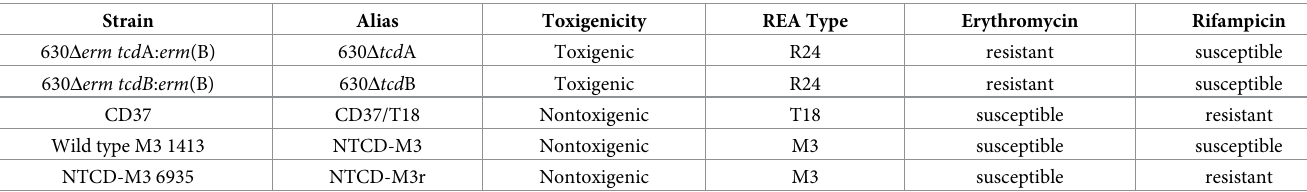
Table 1. Antibiotic resistance characteristics of C . difficile strains used in passive transfer